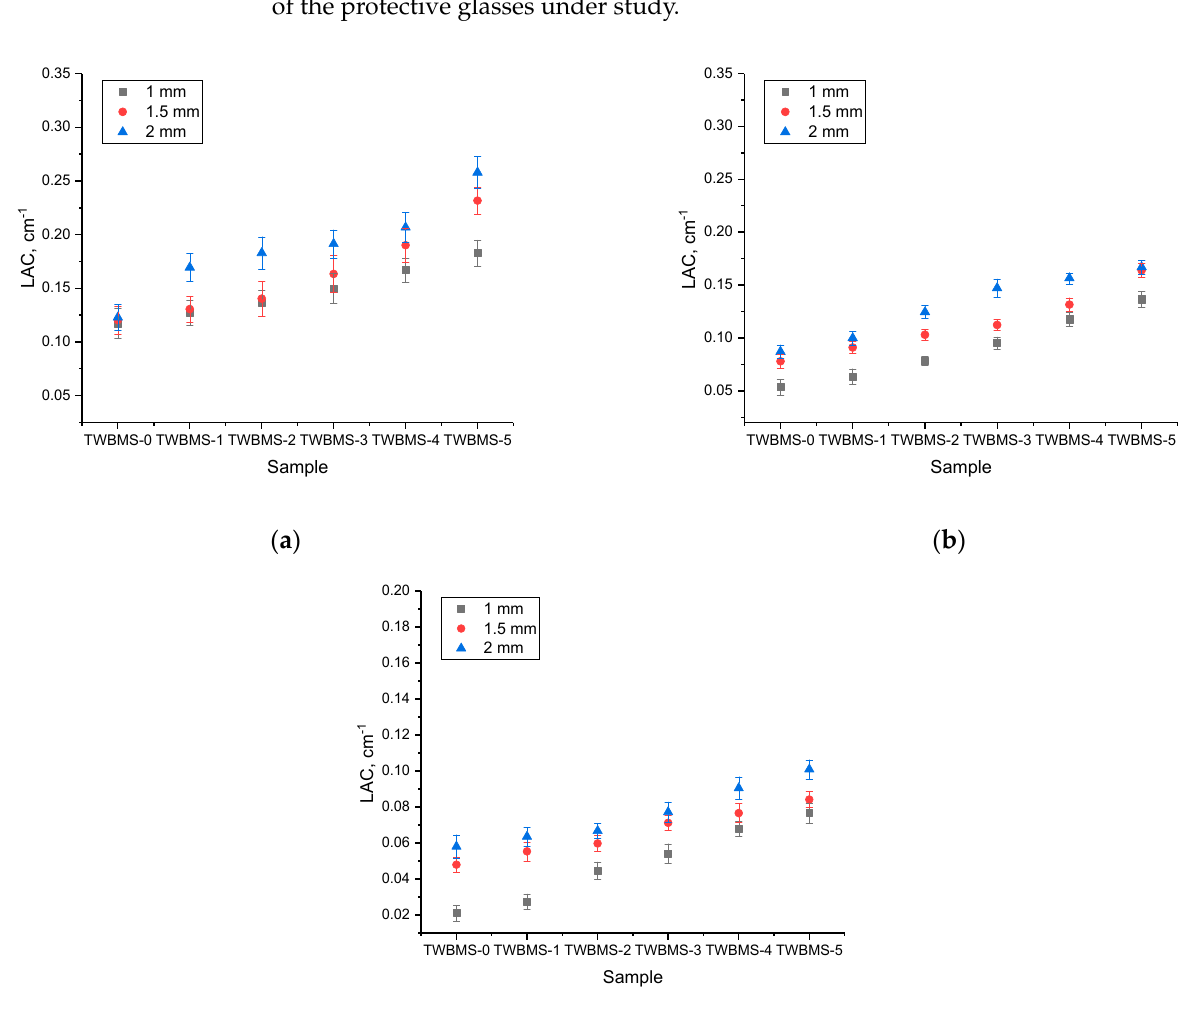
Figure 3. Diagrams of the change in the absorption efficiency of the gamma radiation intensity in comparison with a sample not containing MoO 3 and SiO: ( a ) when shielding gamma rays with an energy of 130 keV; ( b ) when shielding gamma rays with an energy of 660 keV; ( c ) when shielding gamma rays with an energy of 1270 keV.